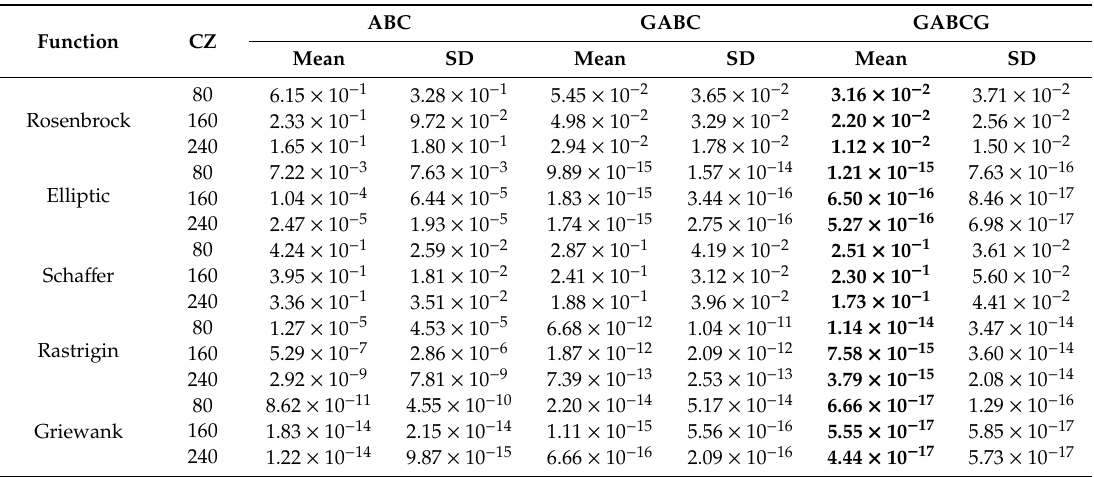
Table 4. Optimization results of the ABC, GABC, and GABCG algorithms with di ff erent colony sizes. Function